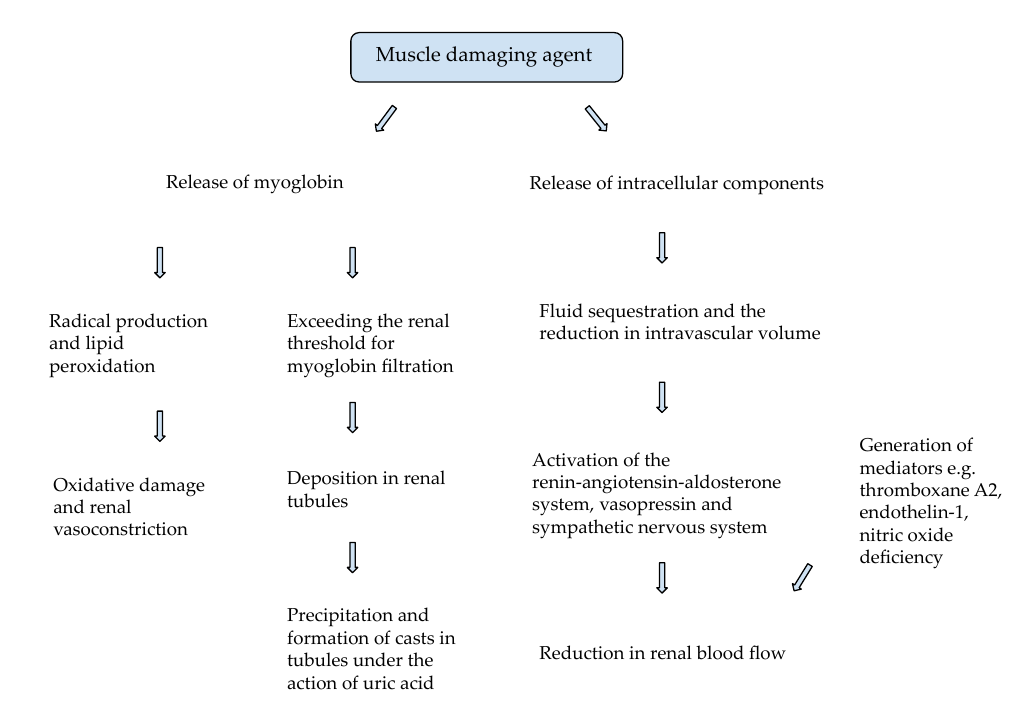
Figure 1. Pathomechanism of rhabdomyolysis-induced AKI (RIAKI)